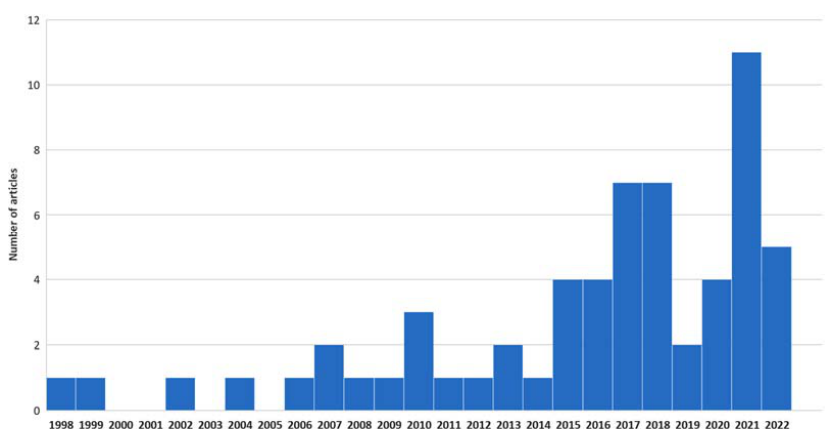
Figure 1. Review flow chart.